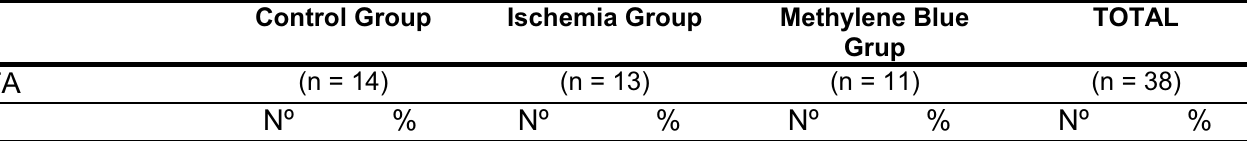
TABLE 2 - Macroscopic evaluation of the study